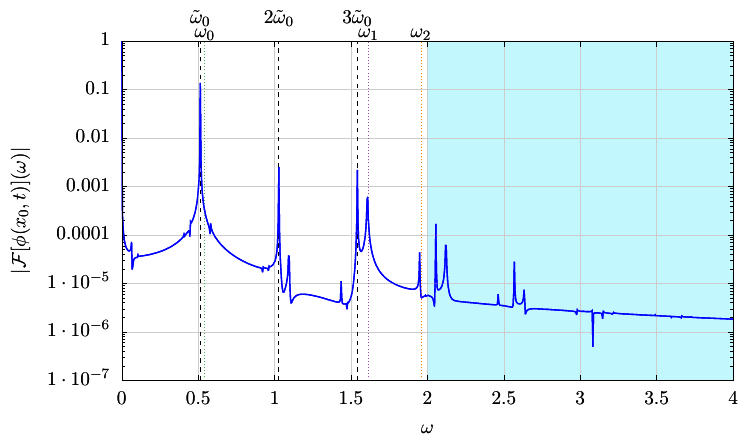
Figure 15 . Power spectrum for the exited lump (interpreted as an oscillating kink-antikink pair) for (cid:11) = (cid:0) 1 : 2. The shown values ! 0 , etc. correspond to the linear analysis and, therefore, do not exactly coincide with the peaks of the full (numerical) nonlinear power